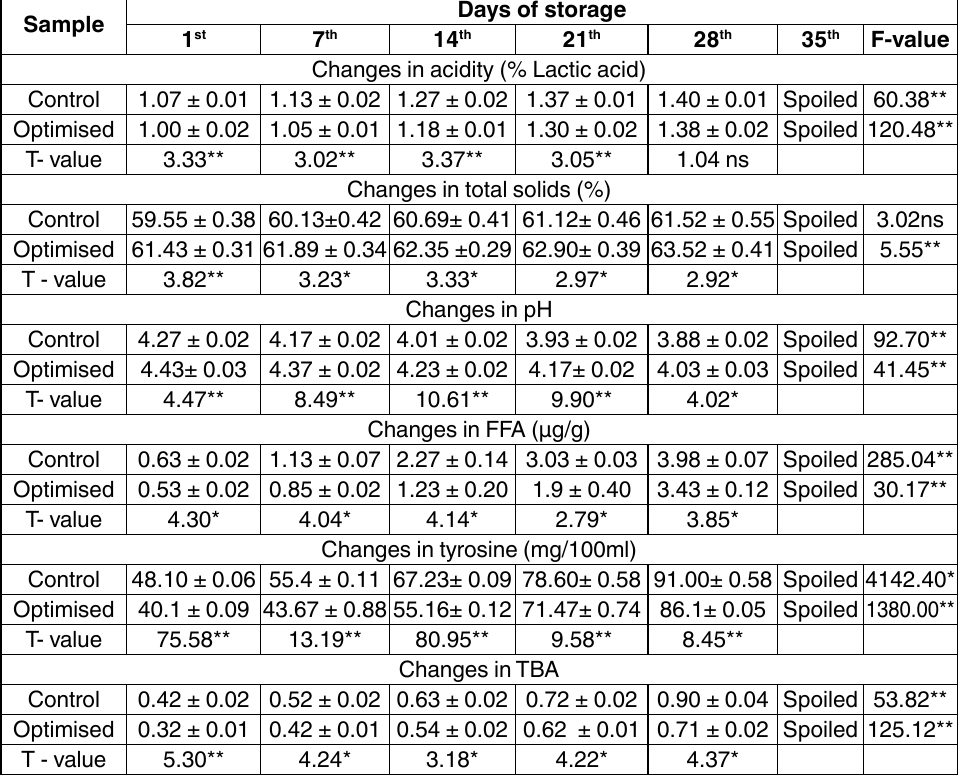
table 1 . Effect of refrigerated storage on physico-chemical attributes of Shrikhand sample